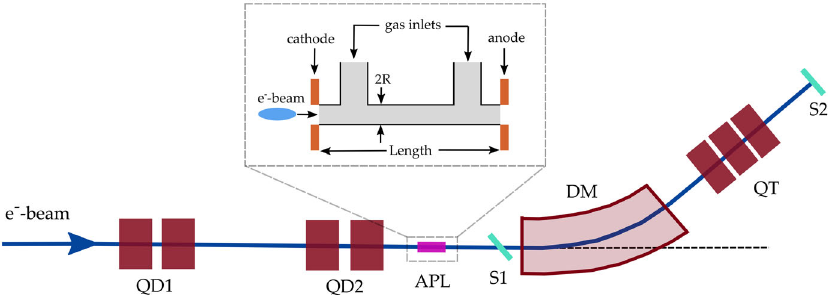
FIG. 2. Schematic of the accelerator beamline at MaMi-B. QD1: first quadrupole duplet; QD2: second quadrupole duplet; APL: active plasma lens; S1: screen used in the offset measurements; DM: dipole magnet; QT: quadrupole triplet used in the emittance measurements; S2: screen used in the emittance